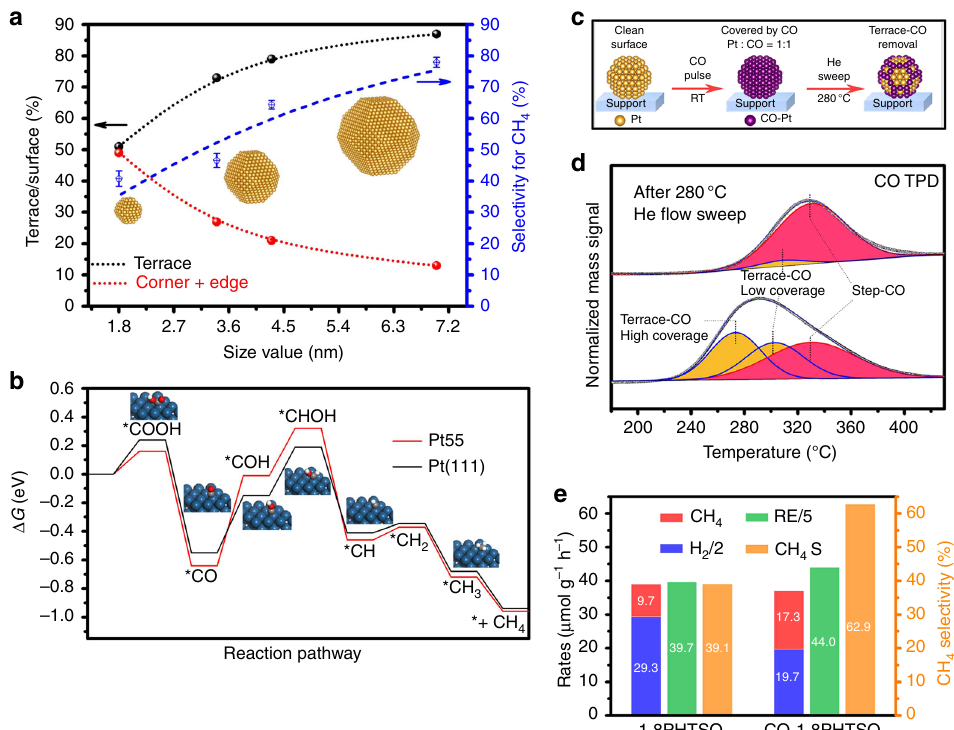
Fig. 5 Size-dependent activity and selectivity of Pt NPs in CO2PR. a Correlations between the selectivity for CH 4 and surface site proportion as functions of the size of Pt NPs in x PHTSO ( x = 1.8, 3.4, 4.3, and 7.0). b Free energy diagrams for CO 2 reduction to CH 4 by the thermochemical model on Pt(111) surface and Pt55. c Scheme illustration of partial CO-modi fi ed 1.8PHTSO through stepwise adsorption and desorption of CO. d CO-TPD results of 1.8PHTSO after CO pulse adsorption and stepwise CO pulse adsorption and He fl ow desorption at 280 °C. e Performance comparisons of CO2PR between 1.8PHTSO and CO-1.8PHTSO, the RE denotes as the reacted electrons, and CH 4 S denotes as the CH 4